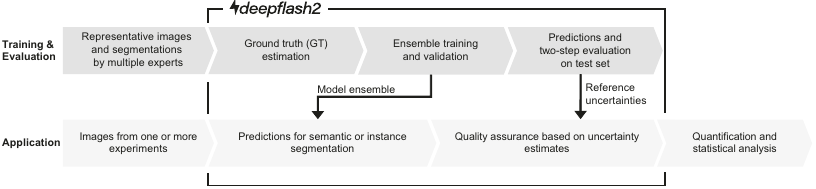
Fig.1|deep fl ash2pipelines. Proposedintegrationofdeep fl ash2intothebioimage analysis work fl ow. In contrast to traditional DL pipelines, deep fl ash2 integrates annotations from multiple experts and relies on model ensembles for training and